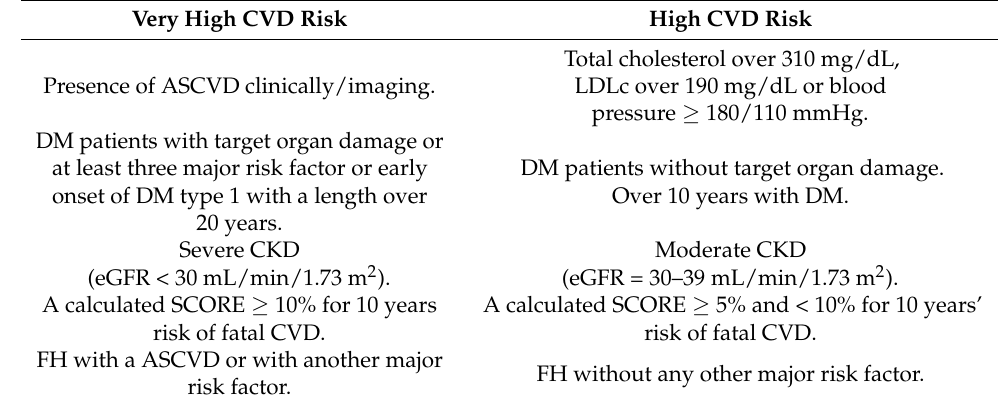
Table 5. Cardiovascular risk criteria based on the 2019 ESC/EAS guidelines used to the recruitment of patients [2]. ASCVD: atherosclerotic cardiovascular disease; DM: diabetes mellitus; CKD: chronic kidney disease; CVD: cardiovascular disease; eGFR: estimated glomerular filtration rate; FH: familial hypercholesterolemia; SCORE: Systematic coronary risk estimation. Adapted from Ref. [2]. Copyright 2019. The European Society of Cardiology and the European Atherosclerosis Association